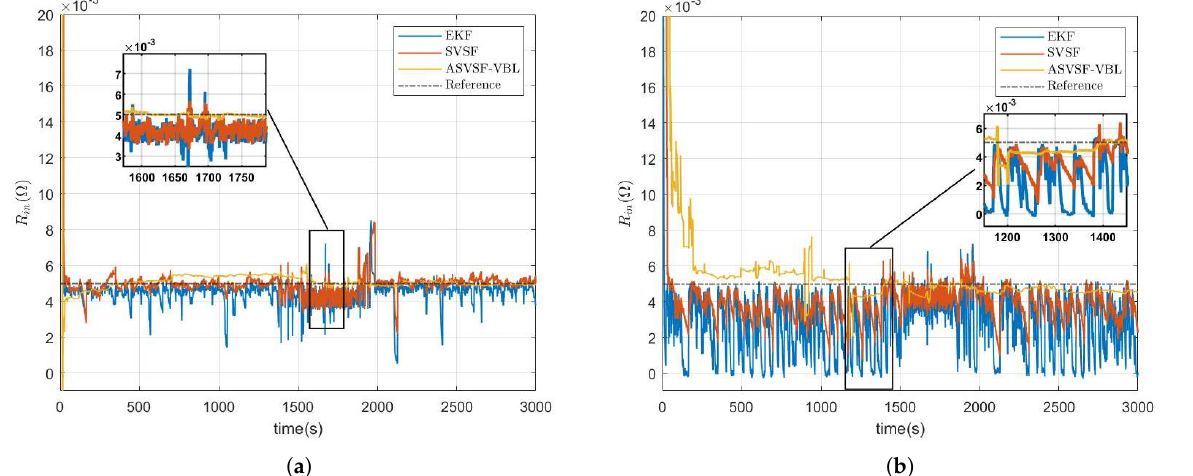
Figure 11. ( a ) Estimated internal resistance for an ideal scenario, ( b ) Estimated internal resistance in presence of noise and current